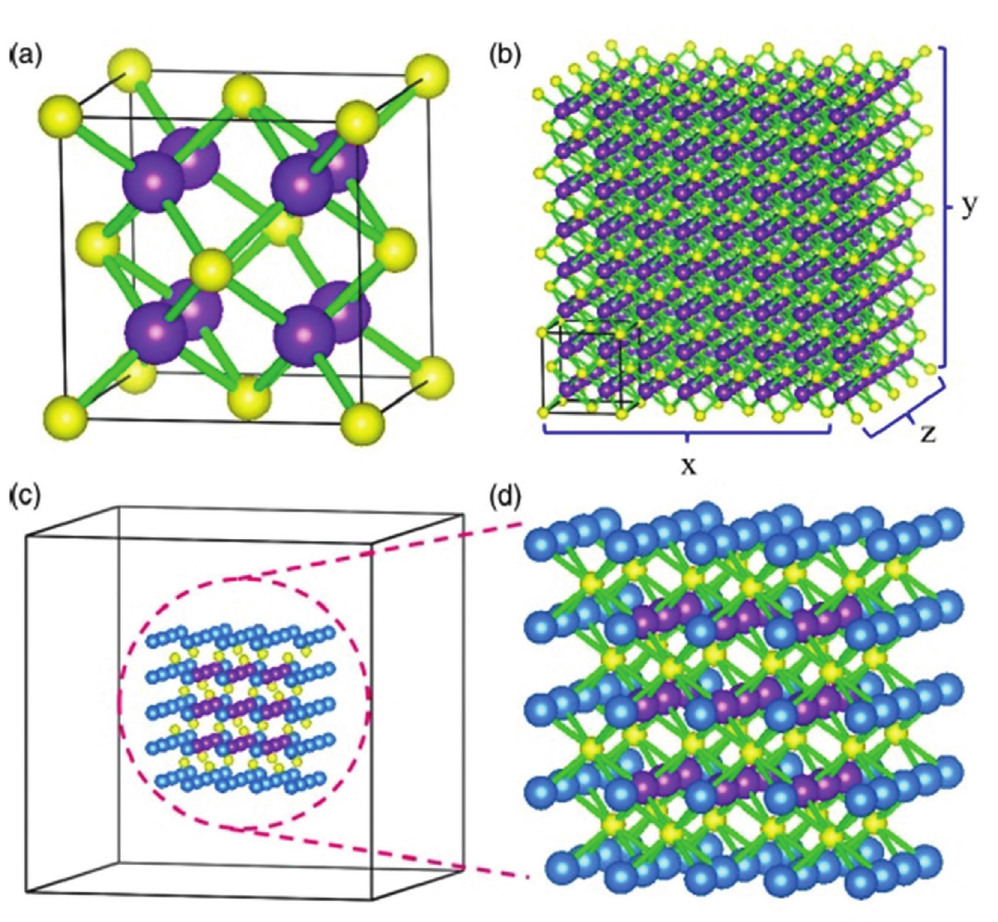
crystal unit is shown in cubic fluorite lattice; (b) constructions of Ce and O atoms by joining the unit cells of CeO Figure 1: (a) CeO 2 in the x, y, and z axis in 3-orthonormal sides (c) supercells of cubical CNP of ~1 nm for relaxation calculations; (d) zoomed picture of the solid collection of atoms (c) to illustrate the crystal construction of {001} - terminat CNPs. Yellow nodes represent Ce atom, purple nodes represent O atom, and blue nodes represents probable cover of O grid which can be partly or completely filled by either distinct O atom or OH.